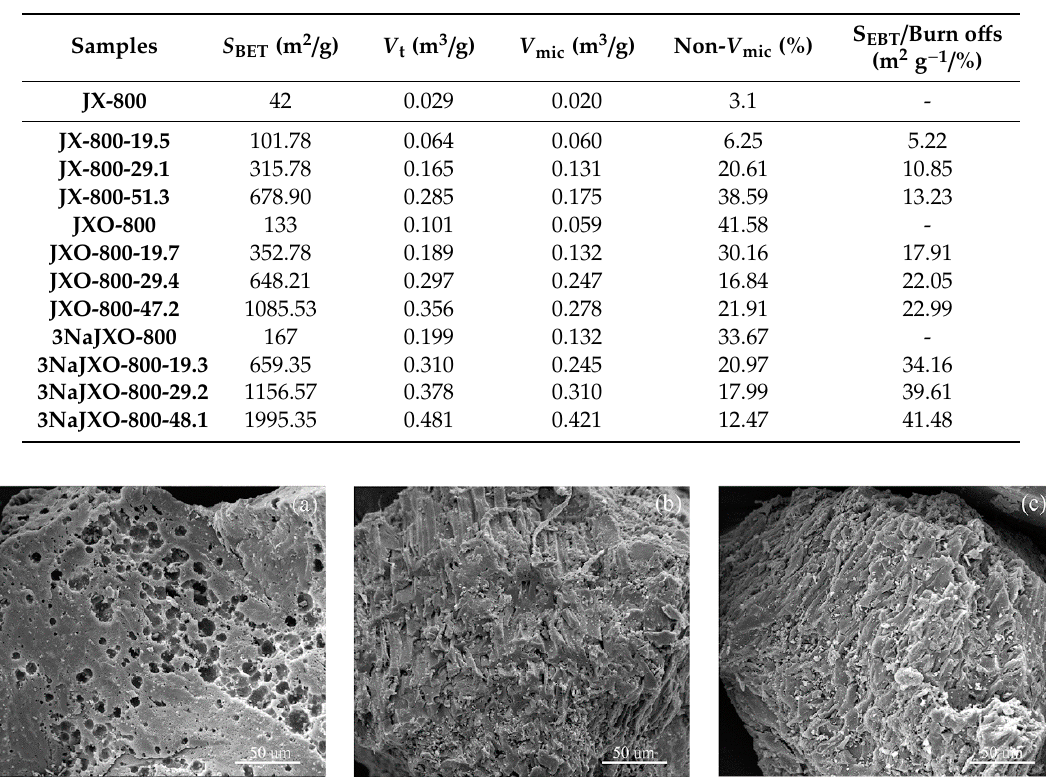
Table 5. Pore structure parameters of typical chars at di ff erent burn o ff s.